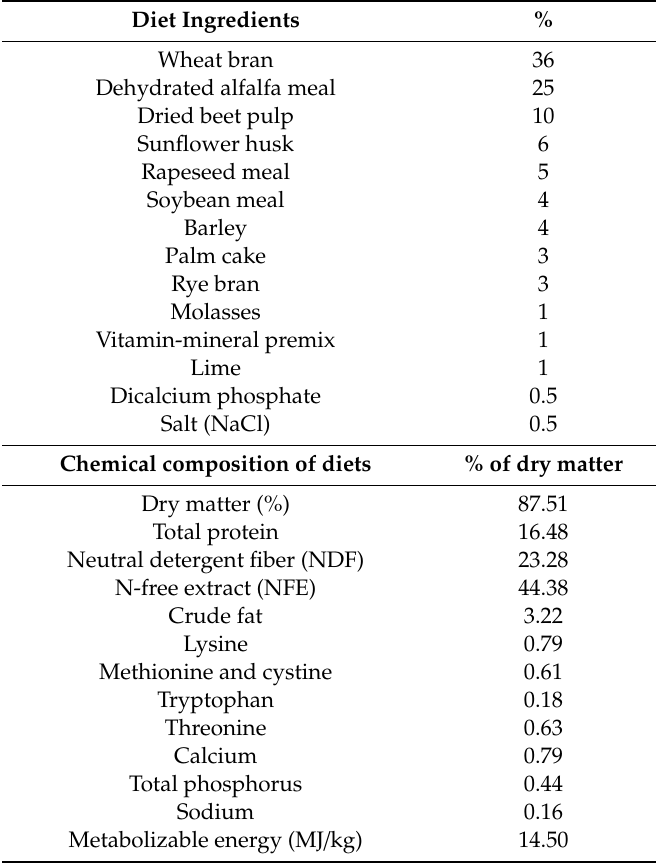
Table 1. Ingredients, chemical composition (% of dry matter), and energy value of diets. Diet Ingredients